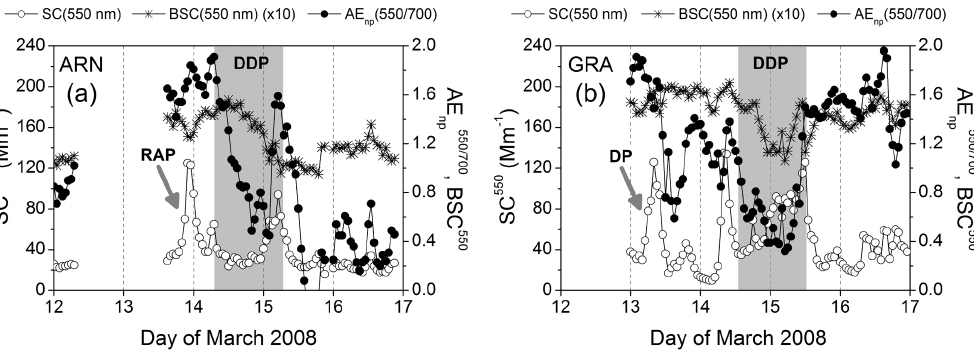
Fig. 13. Temporal evolution of the scattering coefficient at 550nm (SC 550 ), the ˚Angstr¨om Exponent (AE 550 / 700 np ) and the backscatter fraction at 550nm (BSC 550 ) for surface particles with a particle diameter lower than 10µm for the overall period of 12–16 March 2008 in both (a) ARN and (b) GRA sites.